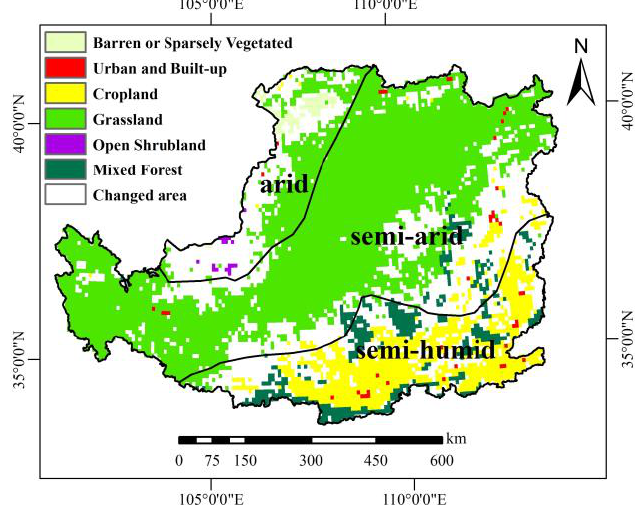
Figure 2. Unchanged vegetation map of MCD12C1 product from 2001 to 2012 in the Loess Plateau.